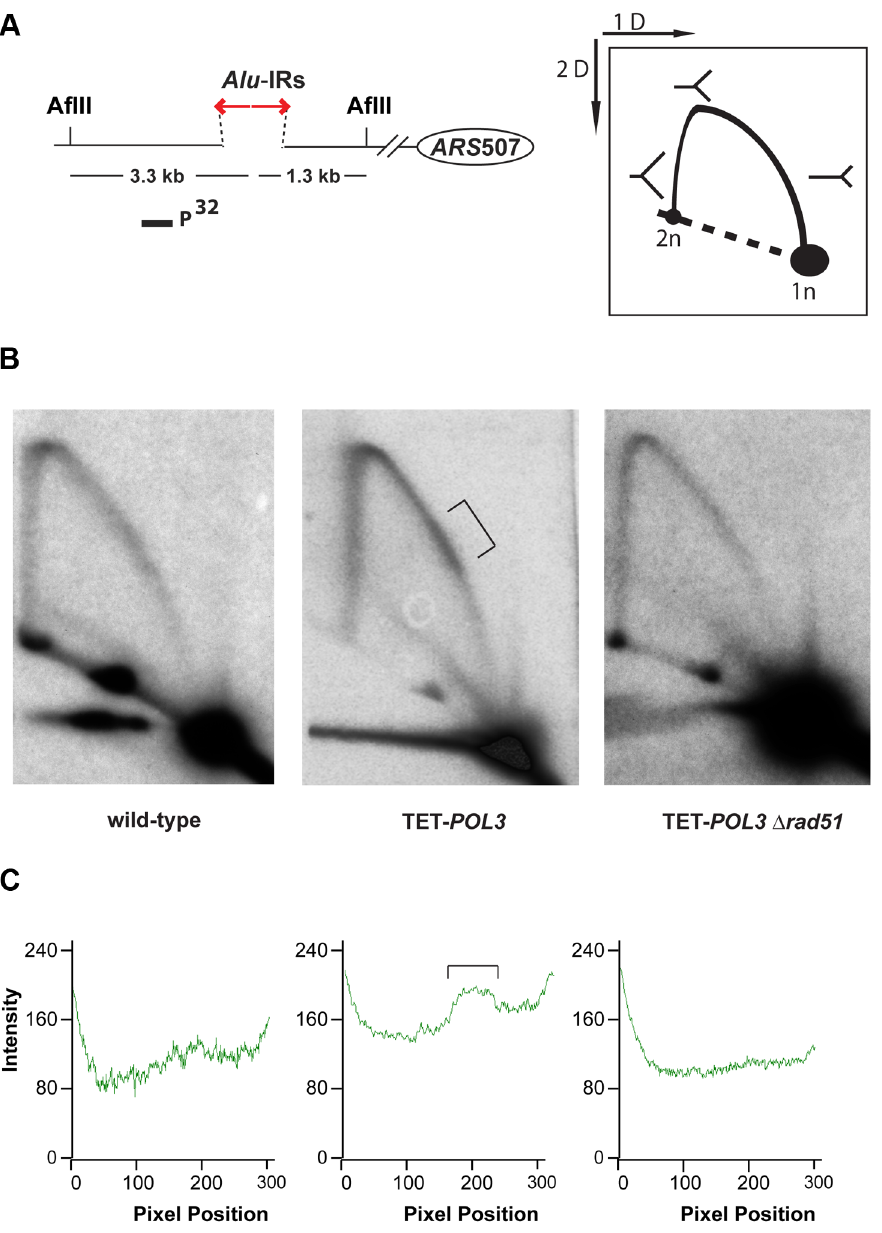
Figure 5. Analysis of replication fork progression through Alu -IRs in the wild-type and mutant strains. DNA samples from the wild-type, TET- POL3 or TET- POL3 D rad51 strains were digested with AflII and processed for 2D gel analysis. (A) Illustration of restriction digestion and 2D gel analysis. The solid rectangle indicates the position of the probe used for Southern hybridization. (B) 2D gel analysis of replication intermediates in the wild-type and mutant strains. The zone of replication arrest in the TET- POL3 strain is indicated by the bracket. (C) Densitometry analysis of the Y arc’s long arm in the corresponding strains in (B). The relative radioactive counts along the long arm of the Y-arc that starts from the monomer are shown. The bracket depicts the zone of replication